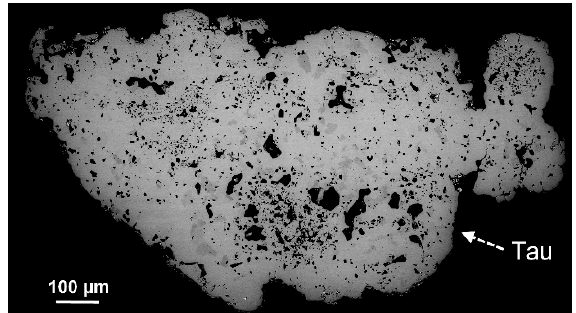
Figure 2. Back-scattered electron image showing the placer grain of platiniferous tetra-auricupride (Tau) from Bolshoy Khailyk. Black inclusions are filled with magnetite; gray phases are Rh–Co-bearing pentlandite and members of the tulameenite–ferronickelplatinum series.